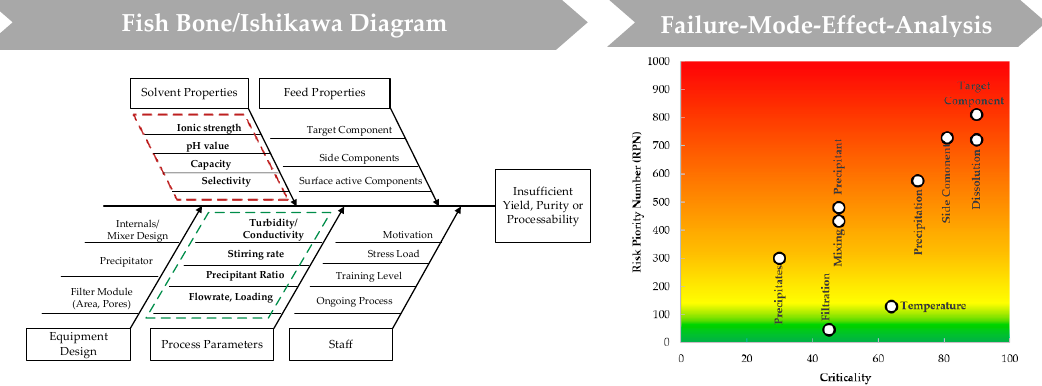
Figure 3. Risk assessment conducted for the unit operation precipitation shown as Ishikawa diagram.